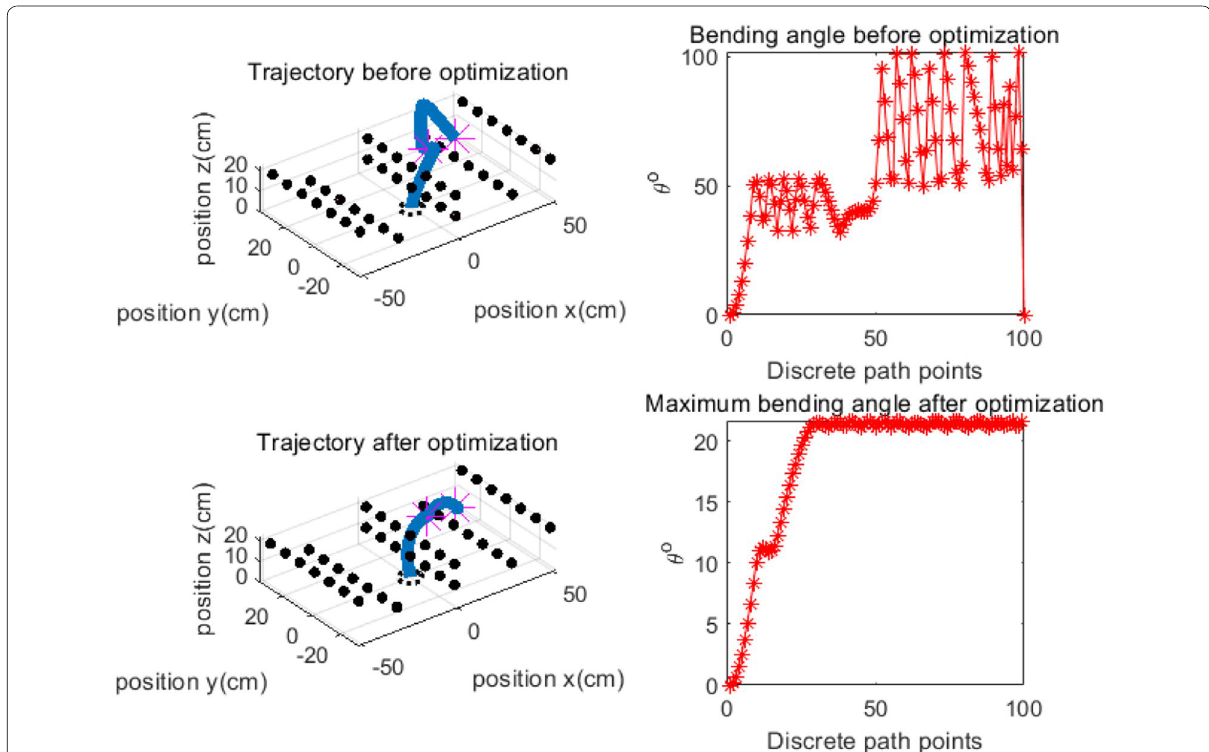
Figure 12 Trajectory and bending